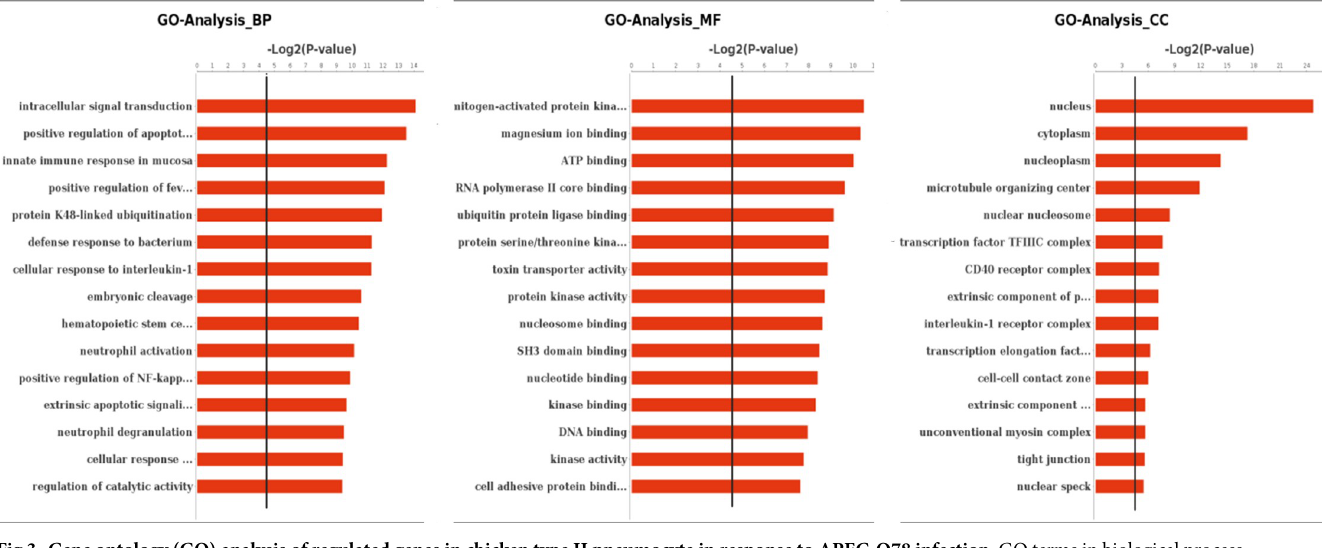
Fig 3. Gene ontology (GO) analysis of regulated genes in chicken type II pneumocyte in response to APEC-O78 infection. GO terms in biological process, molecular function and cellular components. The black line stands for “p = 0.05”.